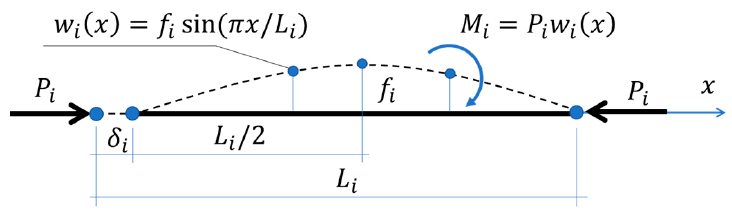
Figure 6. Compression of a single segment with a geometric imperfection.